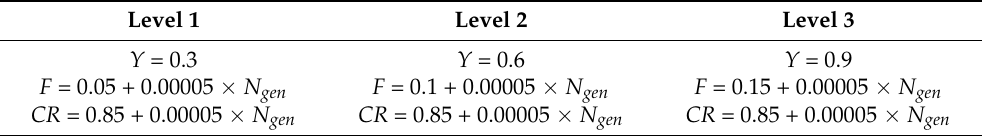
Table 10. Three levels of DE parameter